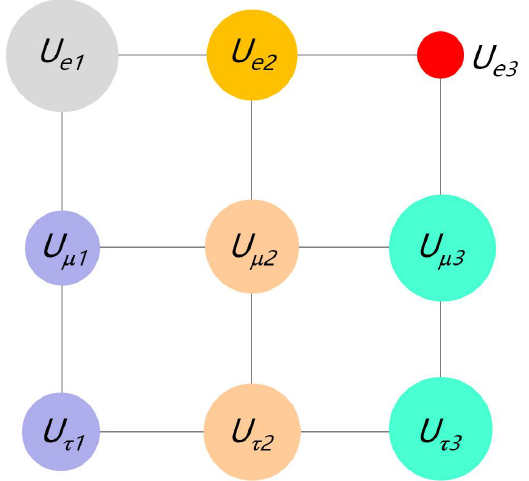
Figure 1 . An illustration of the relative moduli of nine PMNS matrix elements, where the colored area of each circle is proportional to